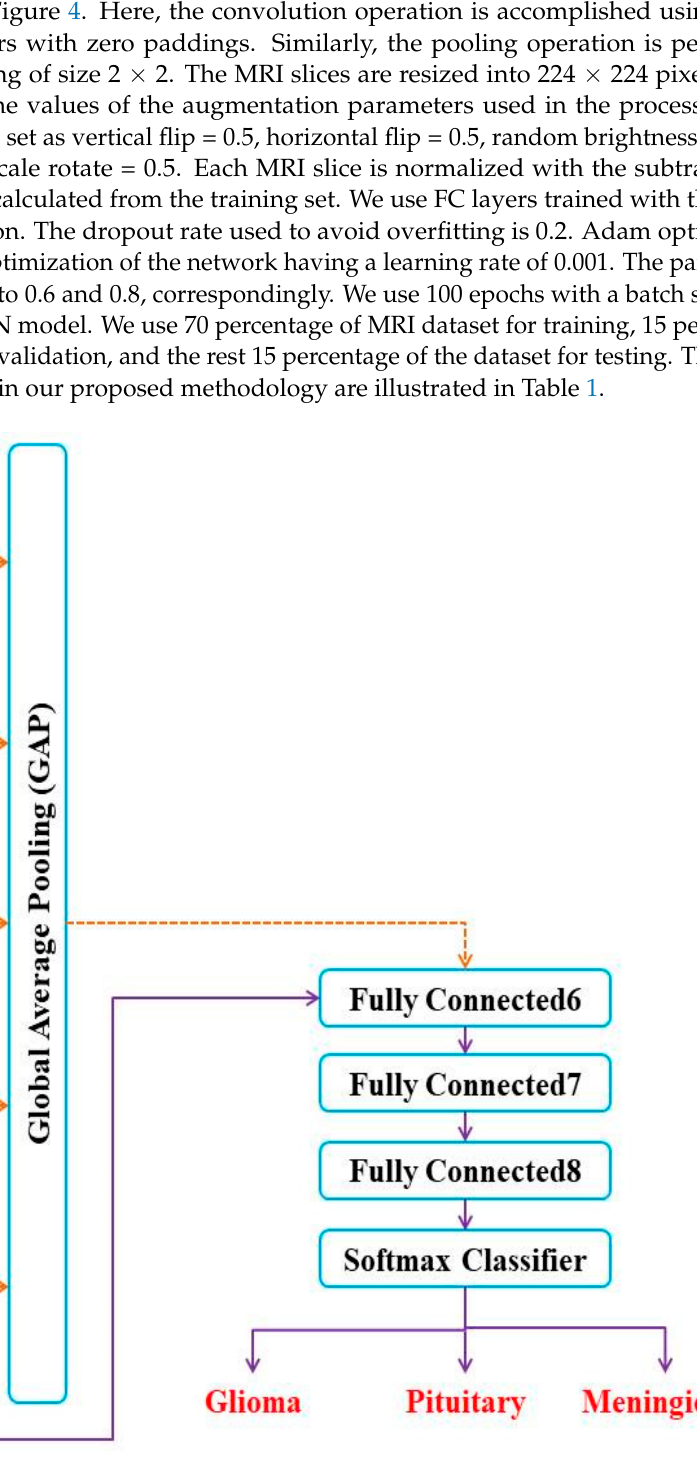
Figure 4. Proposed Transfer Learning based Framework for Brain Tumor Classification using with Pre-trained VGG-16 Network. Table 1. Network Hyper parameters setting in our proposed methodology.